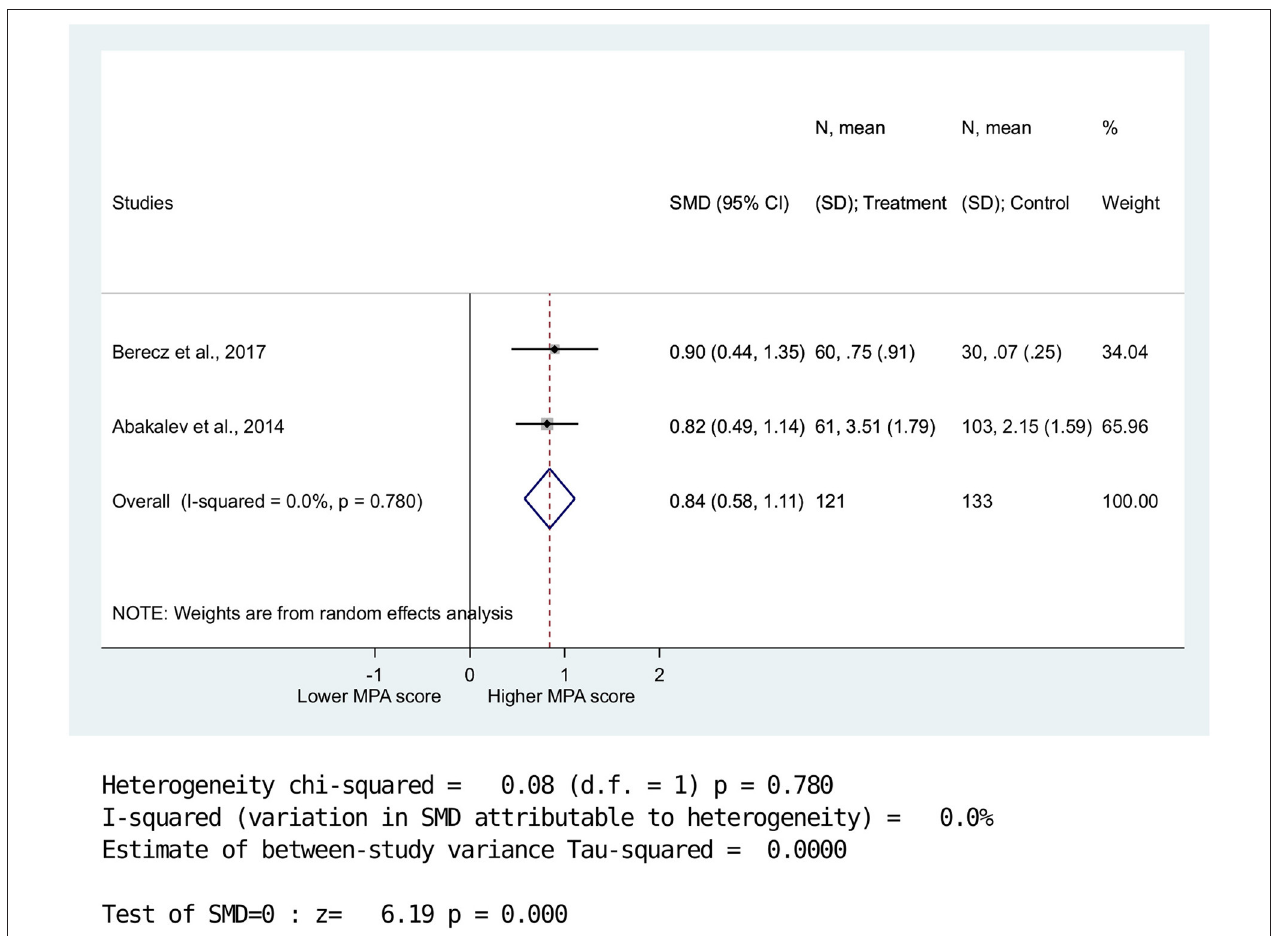
FIGURE 4 | Standardized mean difference of minor physical anomalies in the head and facial regions in patients with bipolar disorders vs. healthy controls. There was significantly higher MPA-CF score in BPD compared to CG. (SMD = 0.84,958%; CI:0.58-1.11, p < 0.001).